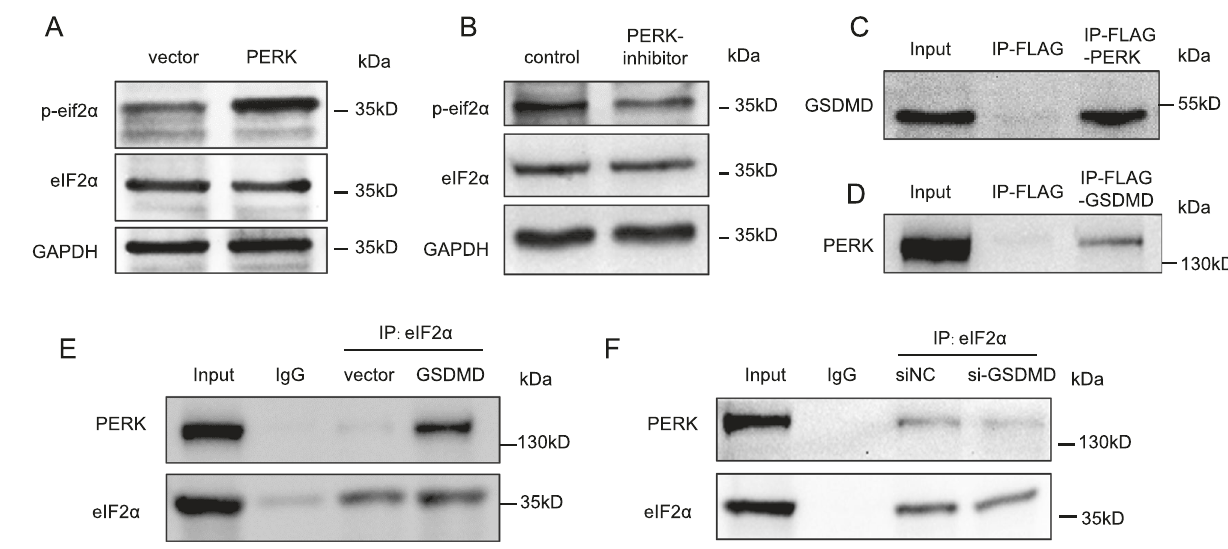
Fig. 4 GSDMD promotes eIF2 α phosphorylation by enhancing the binding of PERK to eIF2 α . A Western blot showing the level of phosphorylated eIF2 α when overexpressed of PERK or ( B ) treated with PERK inhibitor (GSK2606414, 1 μ M, 24 h) in GSDMD-overexpressing cells. C Western blot detecting GSDMD following immunoprecipitation of fl ag-PERK. D Western blot detecting PERK following immunoprecipitation of GSDMD. E , F Western blot following immunoprecipitation showing the change of strength of the binding between GSDMD and PERK when overexpressing ( E ) or knocking down GSDMD ( F